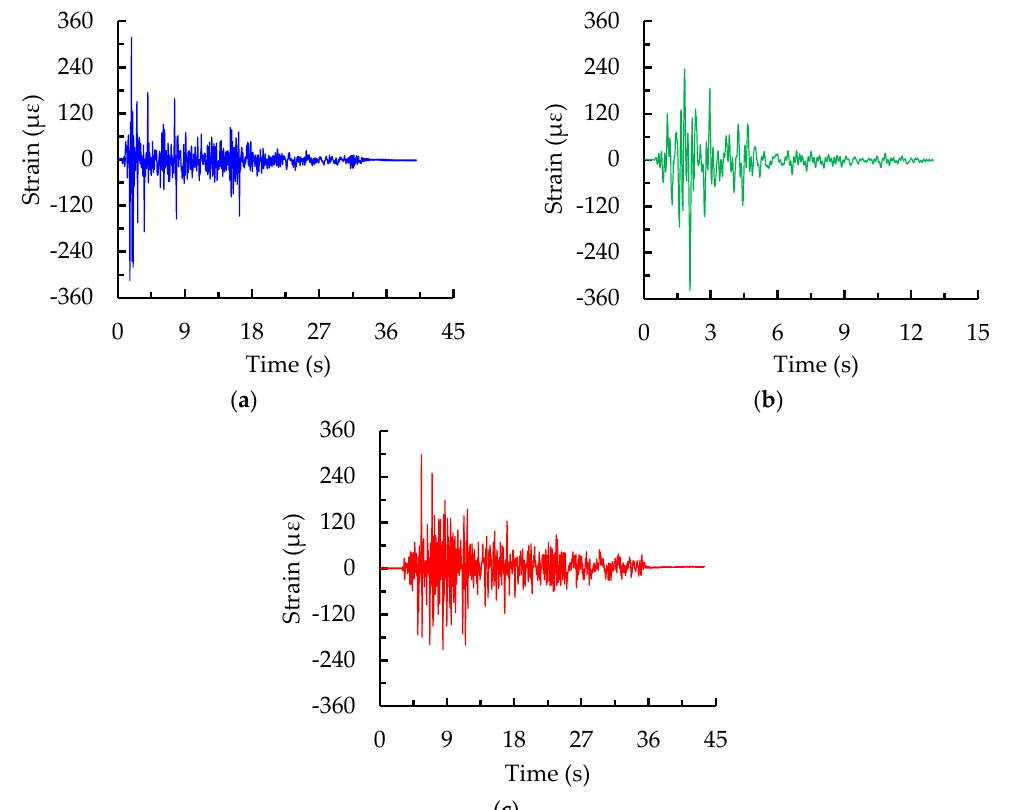
Figure 21. Time-history curves of strains at the bottom of the column under PGA of 1.0 g. ( a ) El Centro wave; ( b ) Kobe wave; ( c ) Taft wave.